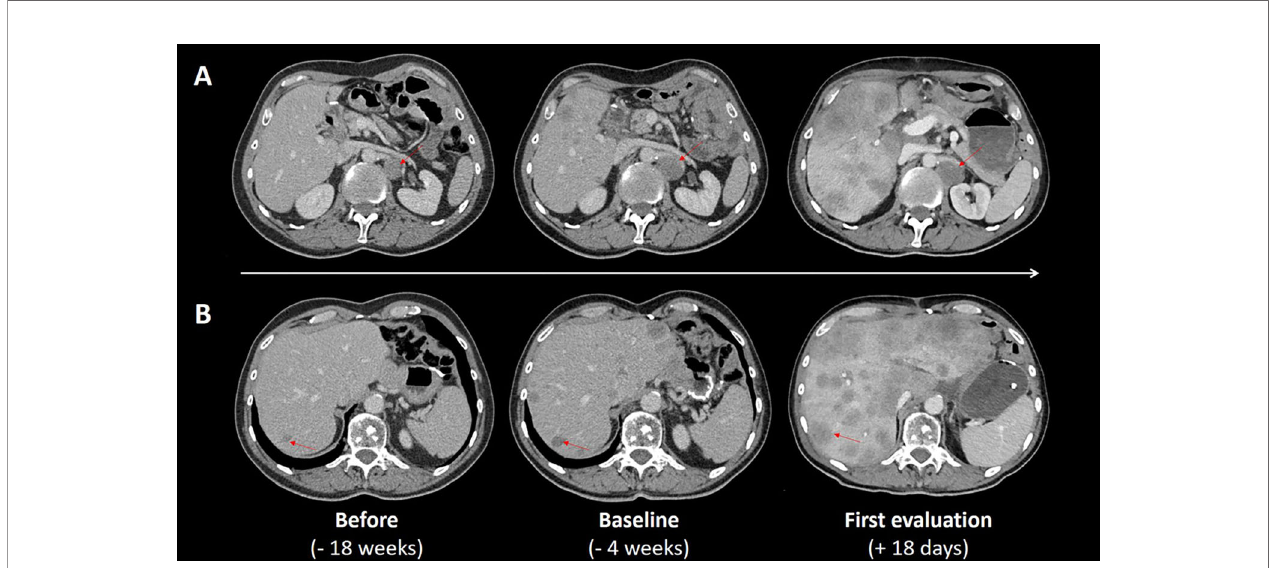
FIGURE 1 | CT scan evaluations before and after treatment. CT scans performed 18 weeks before ICI treatment ( fi rst column), at baseline (second column) and for early evaluation eighteen days after the beginning of ICI treatment (third column) show the changes in lymph nodes and hepatic lesions: the left para-aortic lymph node (red arrow, line A ) increased from 30mm at baseline to 40mm on day 18, known hepatic lesion increased (red arrow, line B ), multiple new hepatic lesions appeared and locoregional invasion led to gastric stump